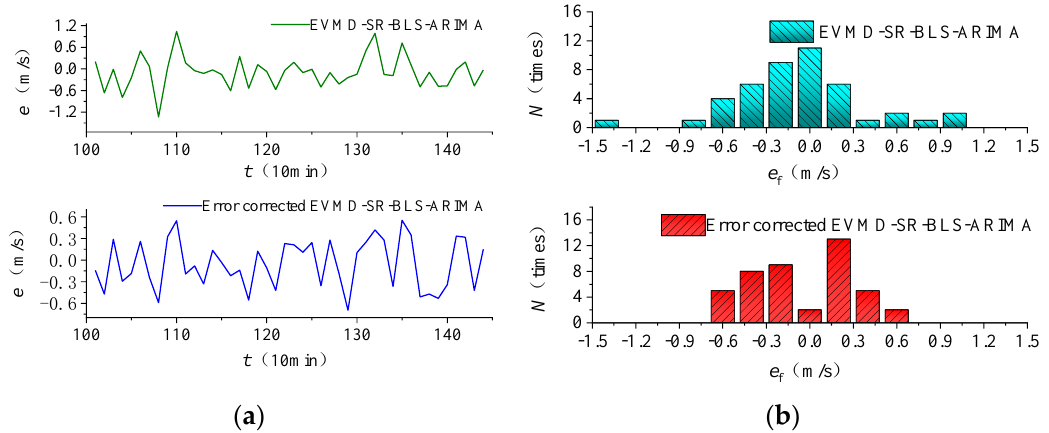
19 of 21 Table 4. Evaluation indexes by EVMD-SR-BLS-ARIMA model. Model